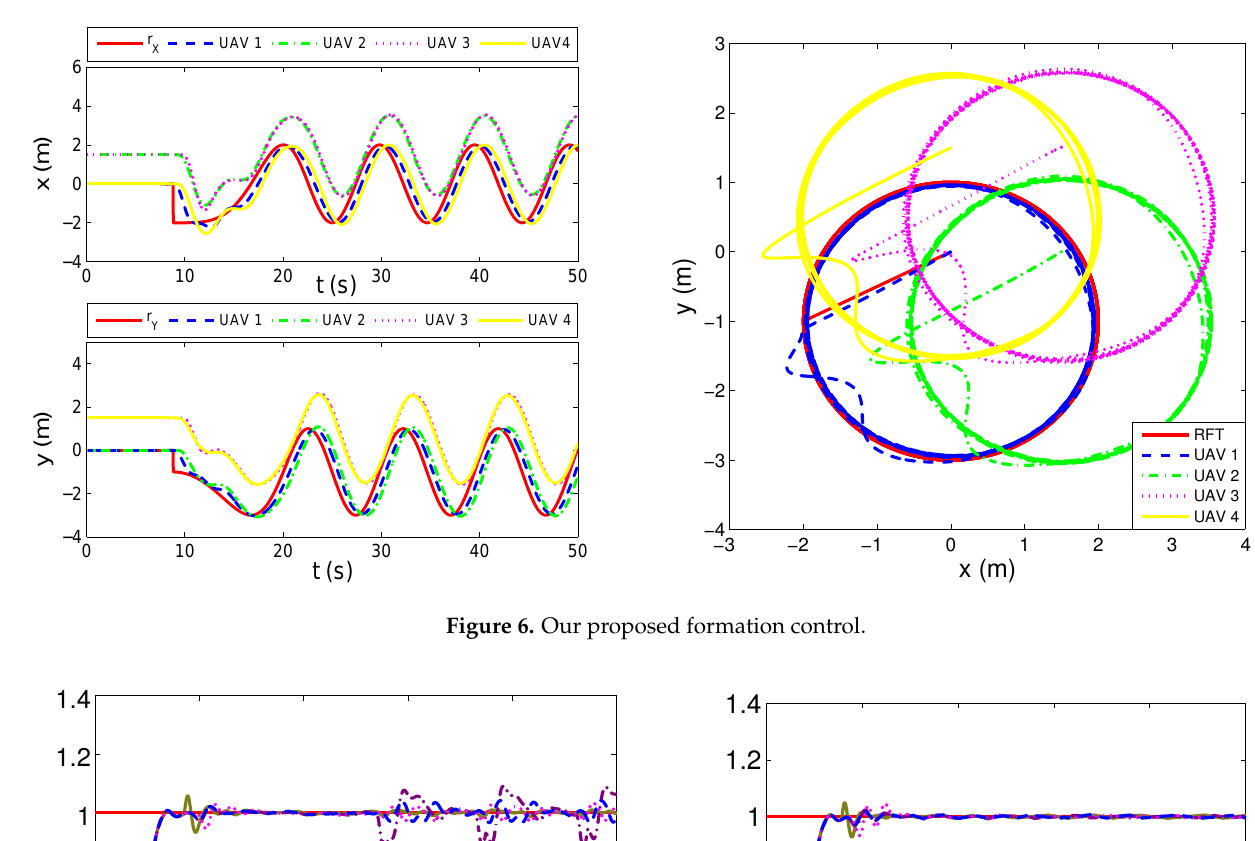
Figure 6. Our proposed formation control.